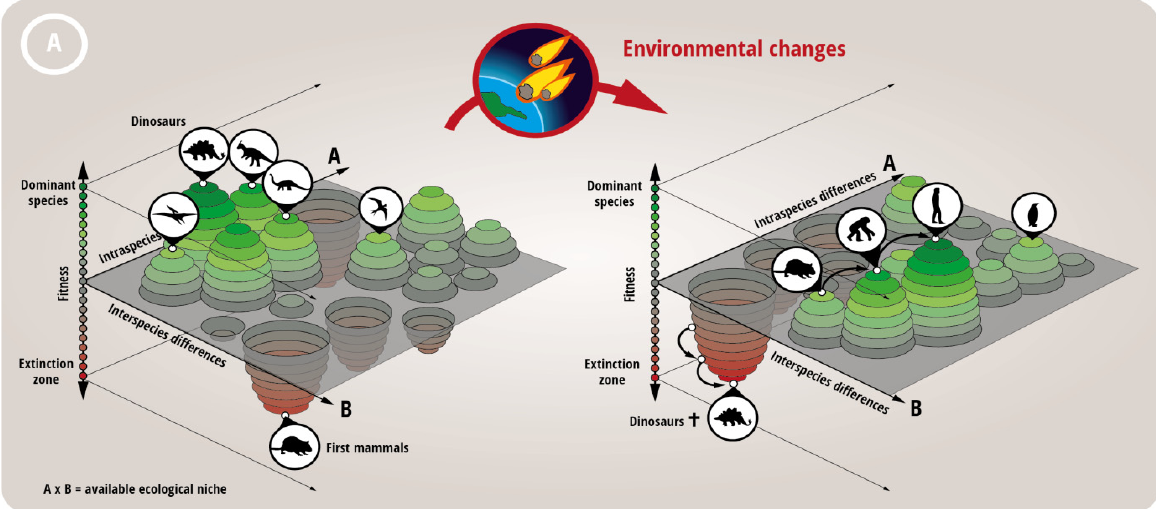
Figure 4. Tumor cell population dynamics and the potential of chronifying treatment strategies. In recent years the subclonal and microenvironment-dependent composition of tumor populations has become apparent. However, lessons learned from population genetics and ecology have only just begun to be applied to the design of novel treatment strategies (for example [81,82,84,85]). ( A ) Probably the best known example of what can happen to species (simplified here as various dinosaurs and a proto-mammal) competing for a single ecological niche (Earth) upon a drastic change in the environment (a comet hitting the planet) is the extinction of the dinosaurs and rise of the mammals during Cretaceous-Paleogene extinction event (better known as K-T extinction). The alterations in the environment (which include the absence of the hitherto dominant species) allow a minor species to repopulate the niche and evolve to new dominance; ( B ) The dynamics described above can also be recapitulated for the ecological niche in which a tumor grows. Therapy causes drastic alterations in the tumor microenvironment (which include the absence of the hitherto dominant subclone), which can allow a minor, therapy-resistant subclone to repopulate the niche and evolve to new dominance (lower left). Traditionally alternative therapeutic approaches or dose escalation are then attempted to control the malignancy. An alternative approach, as suggested by [83] and shown in the lower right, is to reduce the overall fitness of the tumor by reducing the fitness of the dominant clone, but keep the dominance intact. This can result in a stable microenvironment and a disease stasis